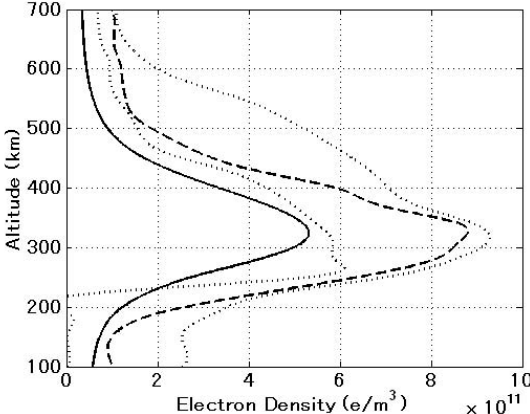
Fig. 10. Ionospheric electron density profile obtained using the RMTNN method. The solid line indicates the profile from the reconstructed data at 07:30–07:45UT on 9 September 2007. The dashed and dotted lines indicate the median and the first and third quartile values, respectively, of the reconstructed data at 07:30– 07:45UT from 25 August to 8 September